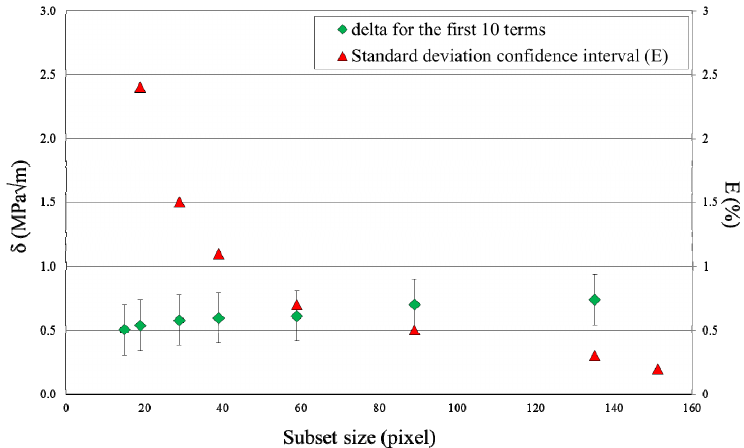
Figure 3. δ as a function of subset size in the magnification of